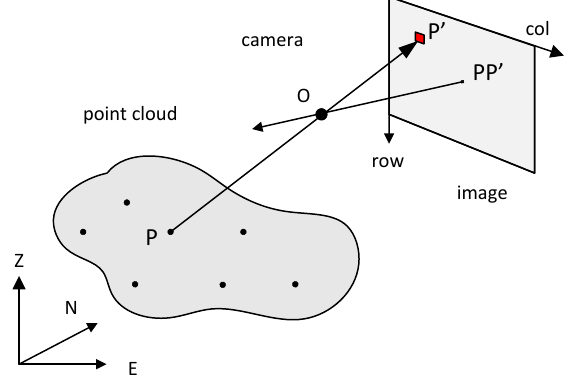
Figure 4. Principle of adding colour information to point clouds by means of back